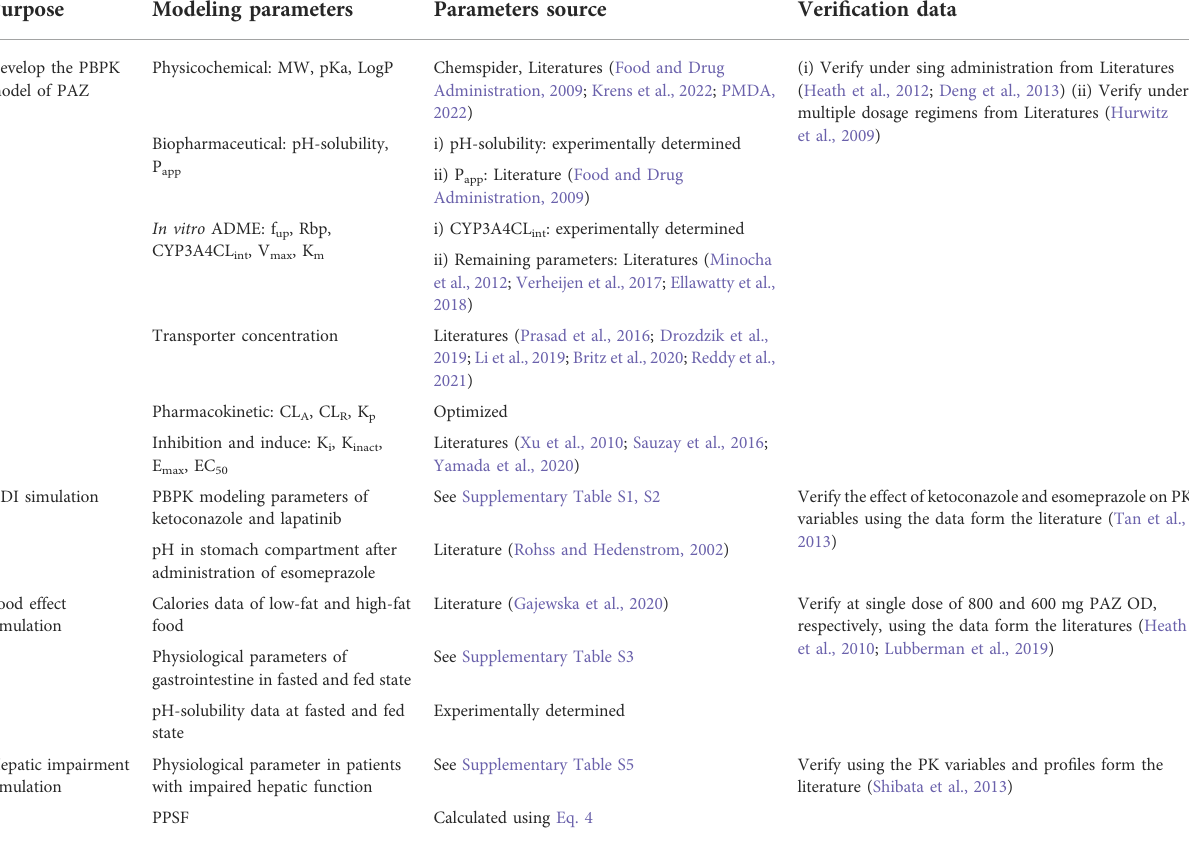
TABLE 3 List of the used modeling parameters and veri fi ed